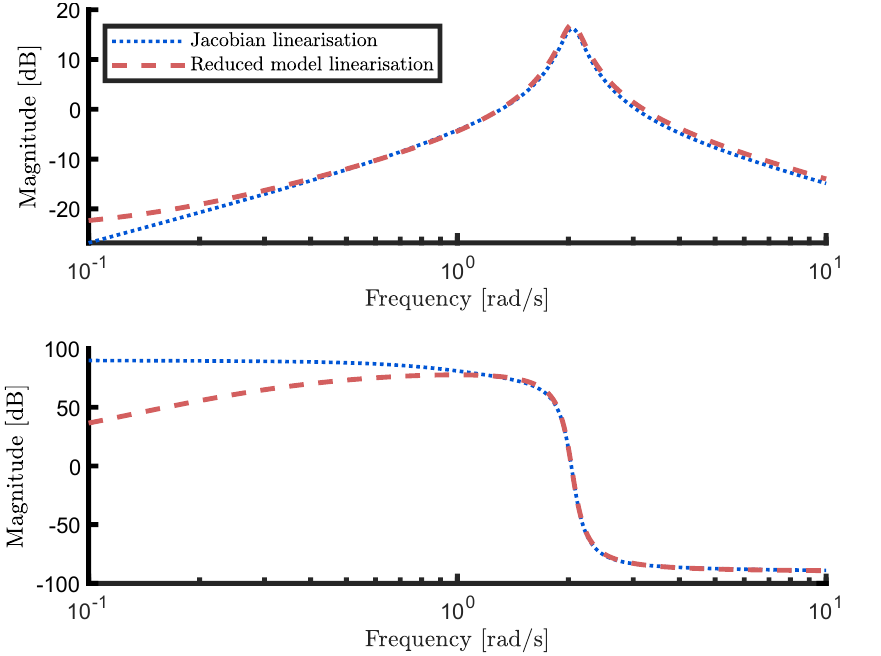
Figure 8. Bode plot of the Jacobian linearisation of the WEC dynamical Equation (5) (dotted-blue), and that associated with the reduced model, i.e., Equation (22).